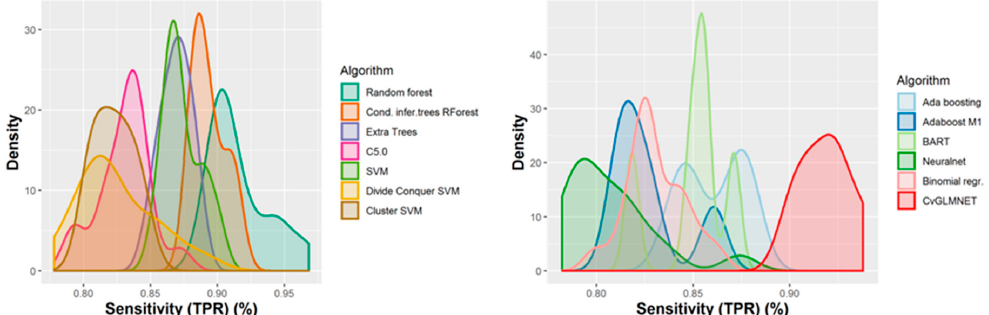
Figure 3. Performance of 165 Quantitative Structure–Activity Relationship (QSAR) models in terms of sensitivity.